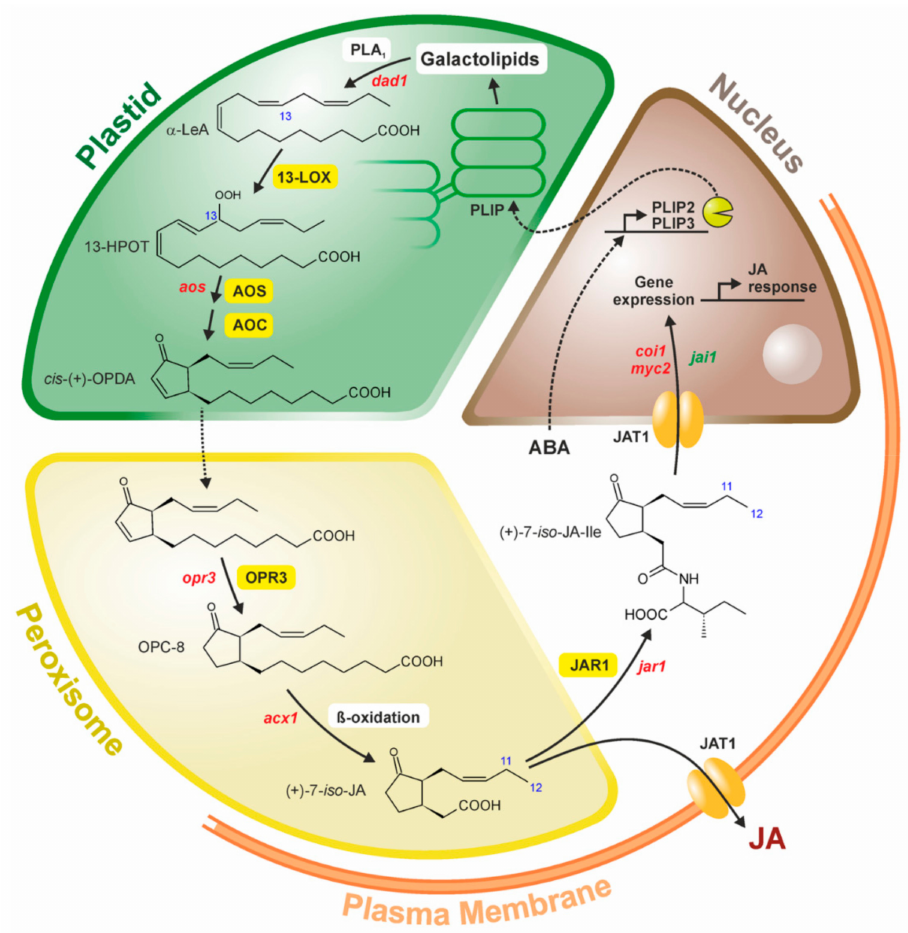
Figure 1. Scheme on Jasmonic Acid/Jasmonic Acid Isoleucine Conjugate (JA/JA-Ile) biosynthesis and action in four different compartments of a plant cell. Upon release of α -linolenic acid by the A 1 -type lipases (PLIP, Plastid Lipase; PLA 1 , Phospholipase A1 of flowers) from galactolipids, cis -(+)-12-Oxophytodienoic Acid ( cis -(+)-OPDA) is formed in plastids by a 13-LOX, AOS and AOC. Following transport into peroxisomes, OPDA is reduced by OPDA reductase3 (OPR3) und undergoes ß-oxidation of the carboxylic acid side chain to JA (shown as the initially formed right configuration (+)- 7-iso -JA). Upon release into the cytosol, JA is conjugated with amino acids by JAR1 or exported by a JA-transporter JAT1. The same transporter allows import of JA-Ile into the nucleus, where JA-Ile perception and JA-Il-induced gene expression takes place (for details and references cf. Part 3). Mutants known for Arabidopsis (red) or tomato (green) are